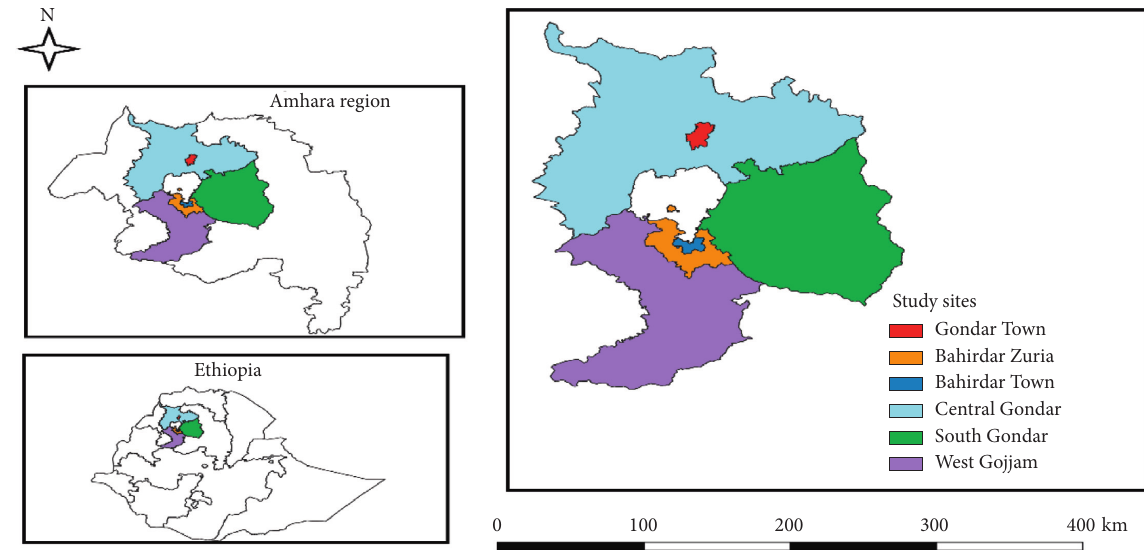
Figure 1: Map of the study